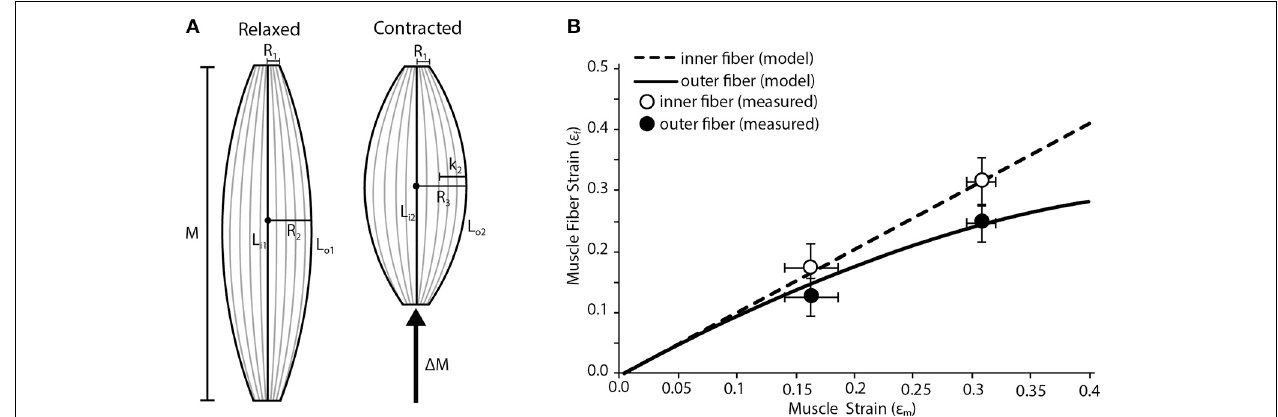
FIGURE 2 | Fiber strain heterogeneity in a fusiform muscle. (A) Schematic of a fusiform muscle during relaxed and contracted conditions. Schematic is representative of a frog palmaris longus muscle. M denotes relaxed length of the muscle. L I1 , the length of the inner fiber, is compared to L o1 , the length of the outer fiber. During contraction there is a change in muscle length ( (cid:2) M) along the line of action of the muscle. L I2 , the length of the inner fiber after contraction, is compared to L 02 , the length of the outer fiber after contraction. The radius of the muscle increases (by length K 2 ) from R 2 to R 3 during